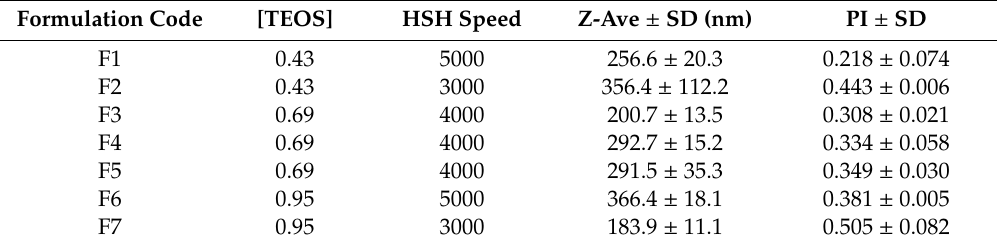
Table 2. Experimental results expressed as mean ± standard deviation (SD) for Z-Ave and PI of di ff erent SiNP formulations. Influence of TEOS (mol / L) and HSH speed (rpm) on the synthesis of SiNP. Formulation